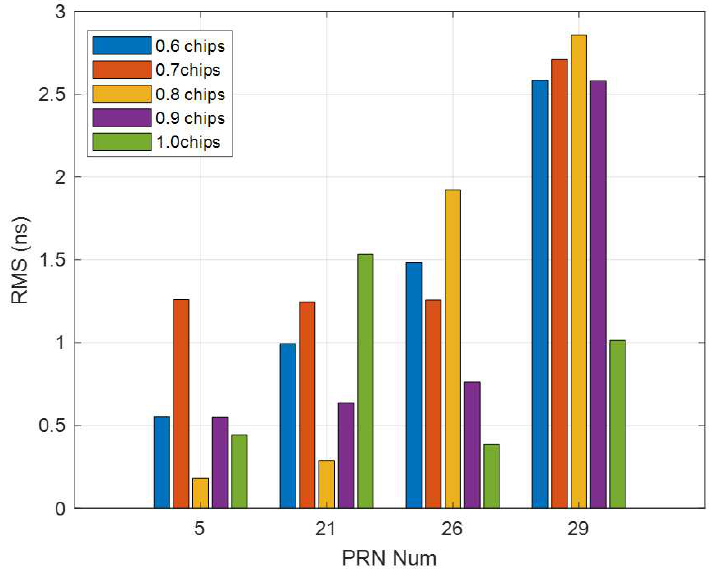
Figure 7. RMS between multi-station (4 IGS stations and 1 correlator spacing flexible receiver) estimated satellite DCBs and CODE products for 21:19–21:34, 16 August